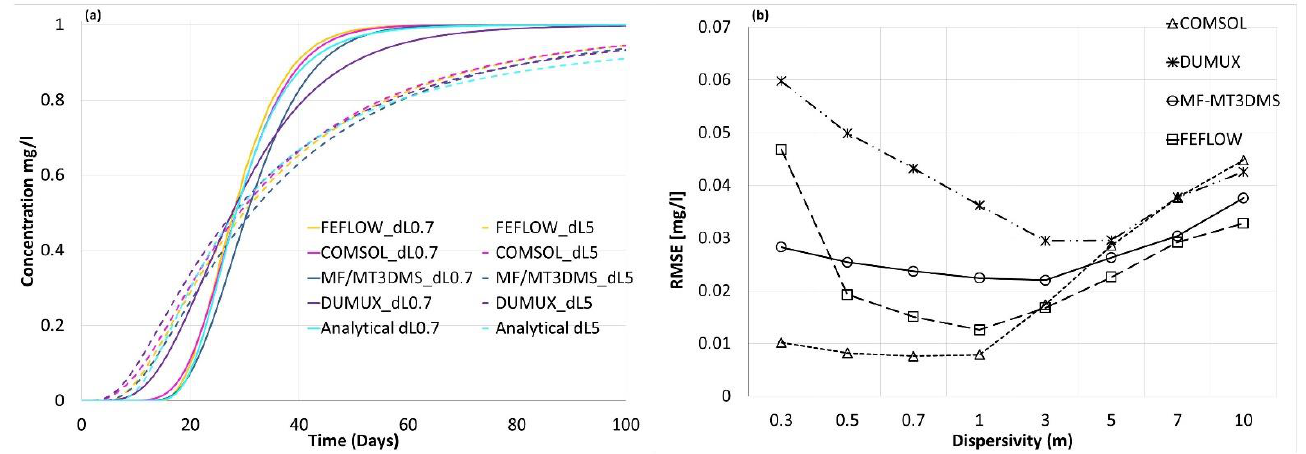
Figure 5. ( a ) Concentration breakthrough for two different dispersivities of 0.7 and 5 m simulated by MODFLOW-MT3DMS, FEFLOW, COMSOL 2D, and DuMu X , and the analytical solution from [19]. ( b ) The relative difference of concentration computed in the numerical simulators from the analytical solution for different dispersivity values for 2D problem.